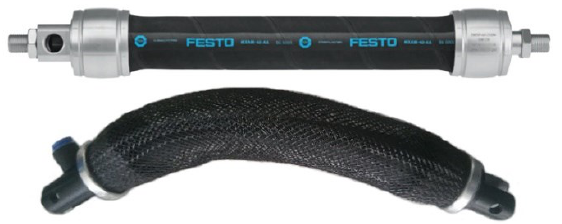
Fig. 1. Festo – Fluidic Muscle DMSP muscle and Shadow Robot Company – Shadow Air Muscle SAM muscle.